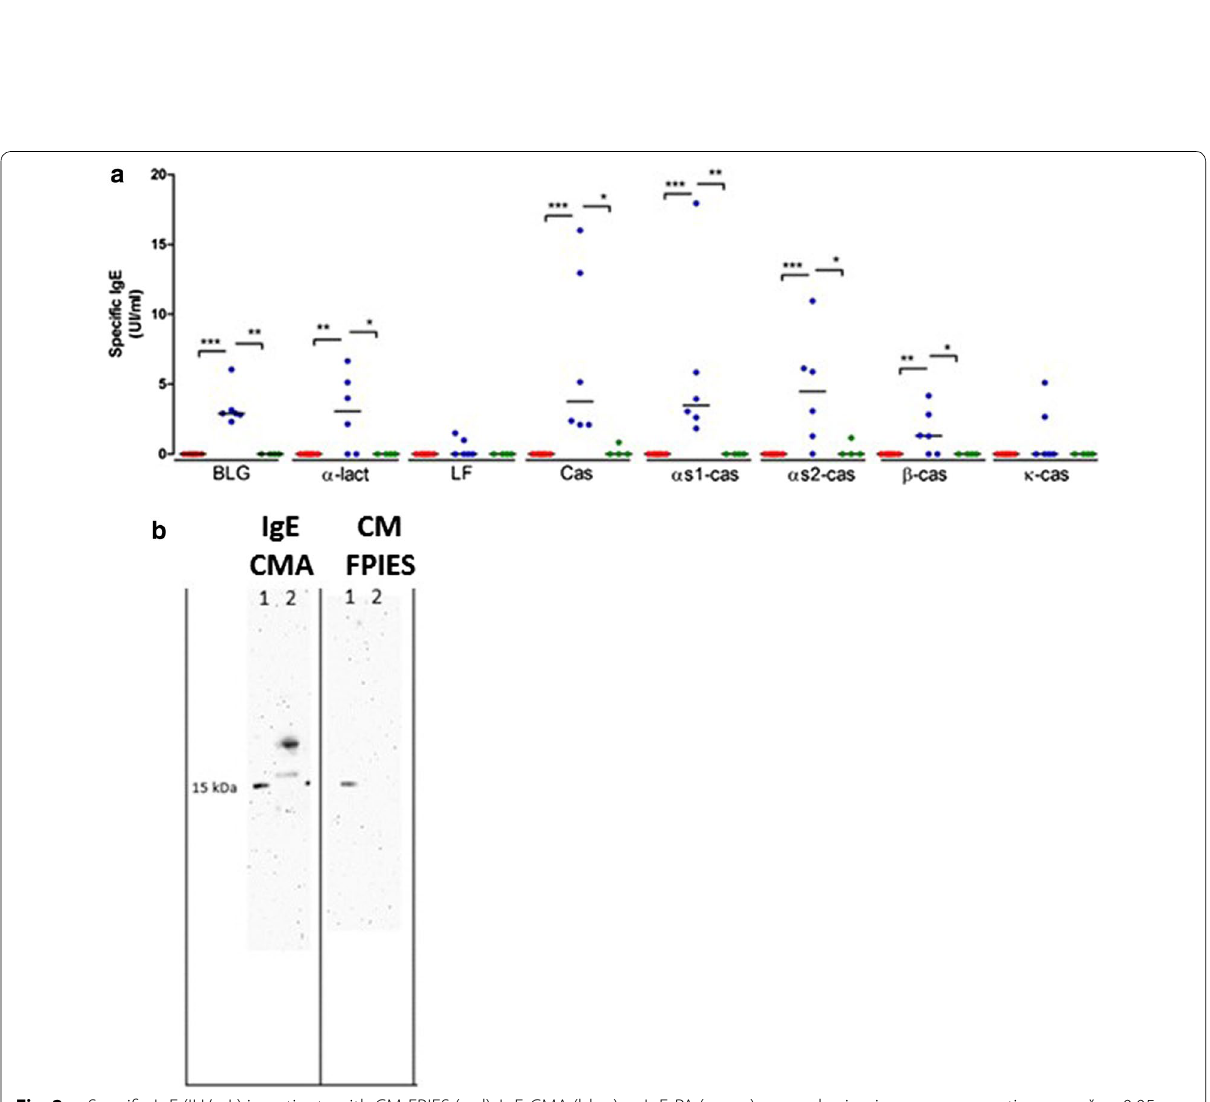
Fig. 2 a Specific IgE (IU/mL) in patients with CM‑FPIES (red), IgE‑CMA (blue) or IgE‑PA (green) assayed using immunoenzymatic assays. * p < 0.05, ** p < 0.01, *** p < 0.001 using the Kruskal–Wallis test and Dunn’s multiple comparison test. b Representative IgE immunoblot of CM proteins using plasma from children with IgE‑CMA (left) or FPIES‑CMA (right). Lane 1: MW markers, Lane 2: CM